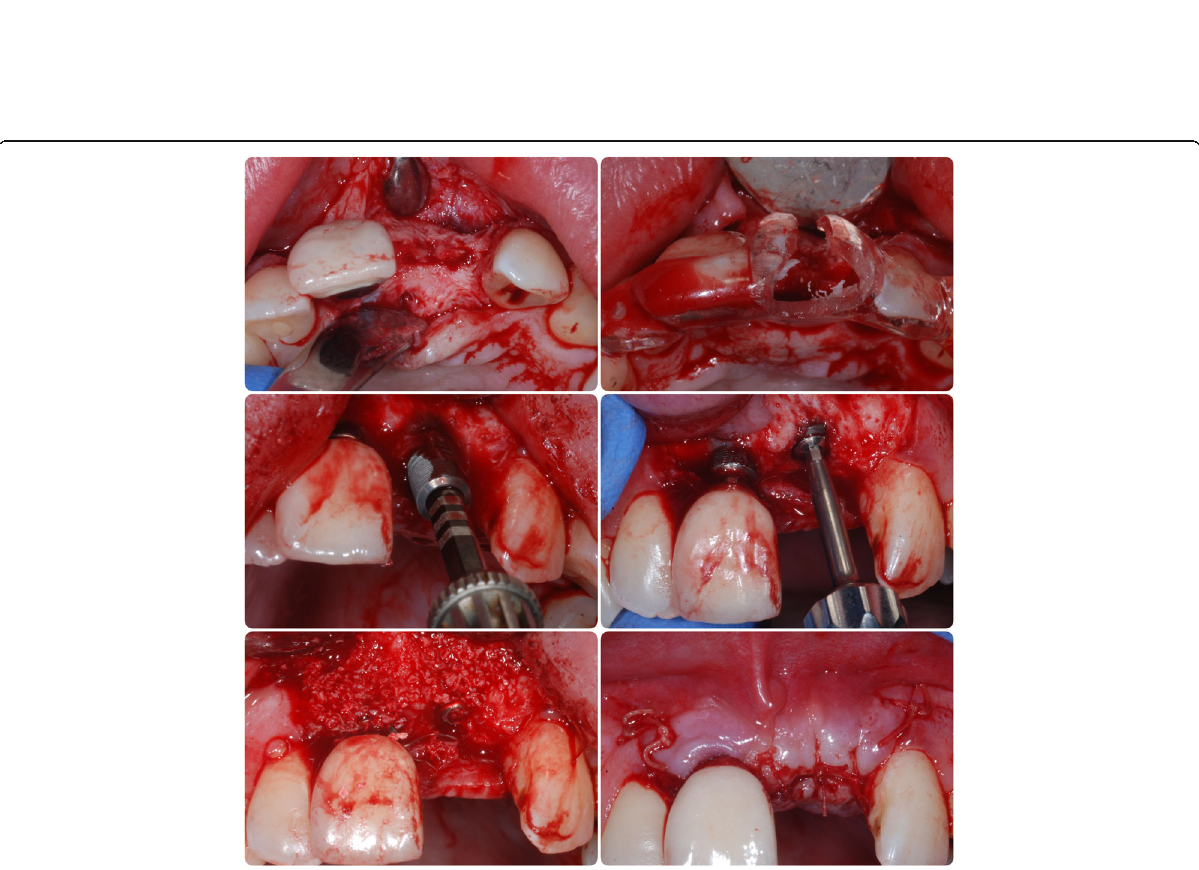
Fig. 7 Additional fixture placement. Surgical stages in fixture placement in position 21 and simultaneous particulate bone